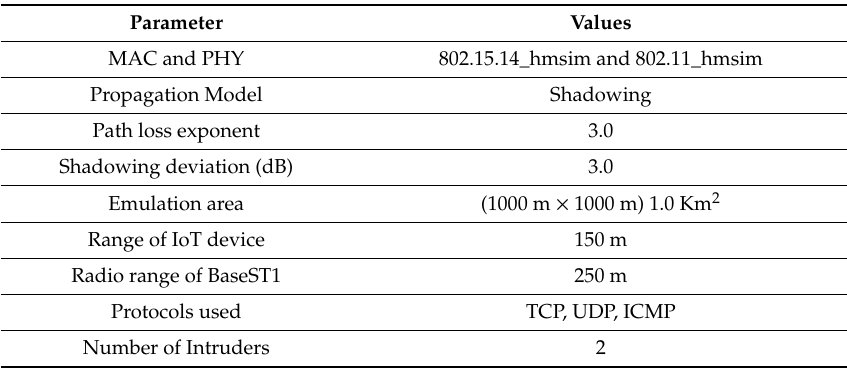
Table 1. Emulation Configuration